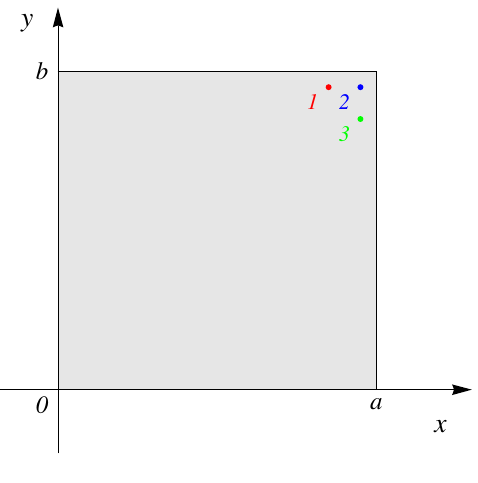
Figure 3. Location of the